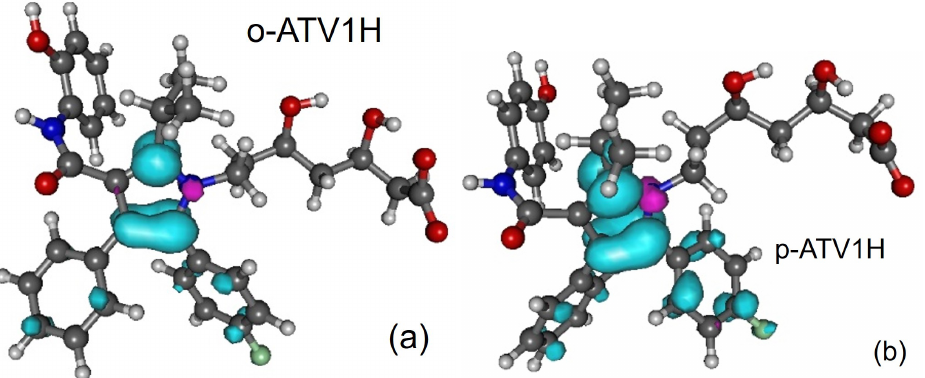
Figure 3. Spin densities of radicals generated by H-atom abstraction at position 1-OH: ( a ) o-ATV1H and ( b ) p-ATV1H. Figure generated using GABEDIT [27].